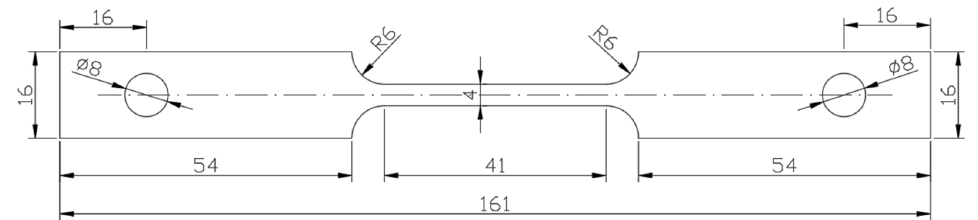
Figure 1. The size (in millimeters) of the SSRT specimen, 2 mm thick.